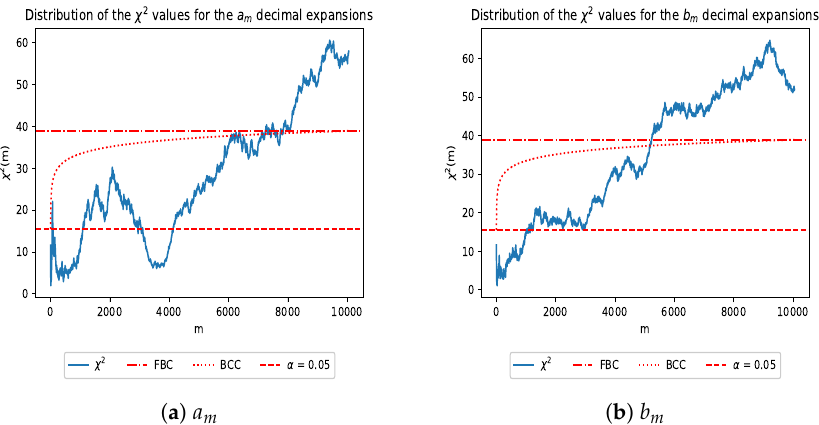
Figure 5. χ 2 distribution for the a m and b m decimal expansions. Legend Guide: FBC-Final Bonferroni Correction, BCC-Bonferroni Correction Curve